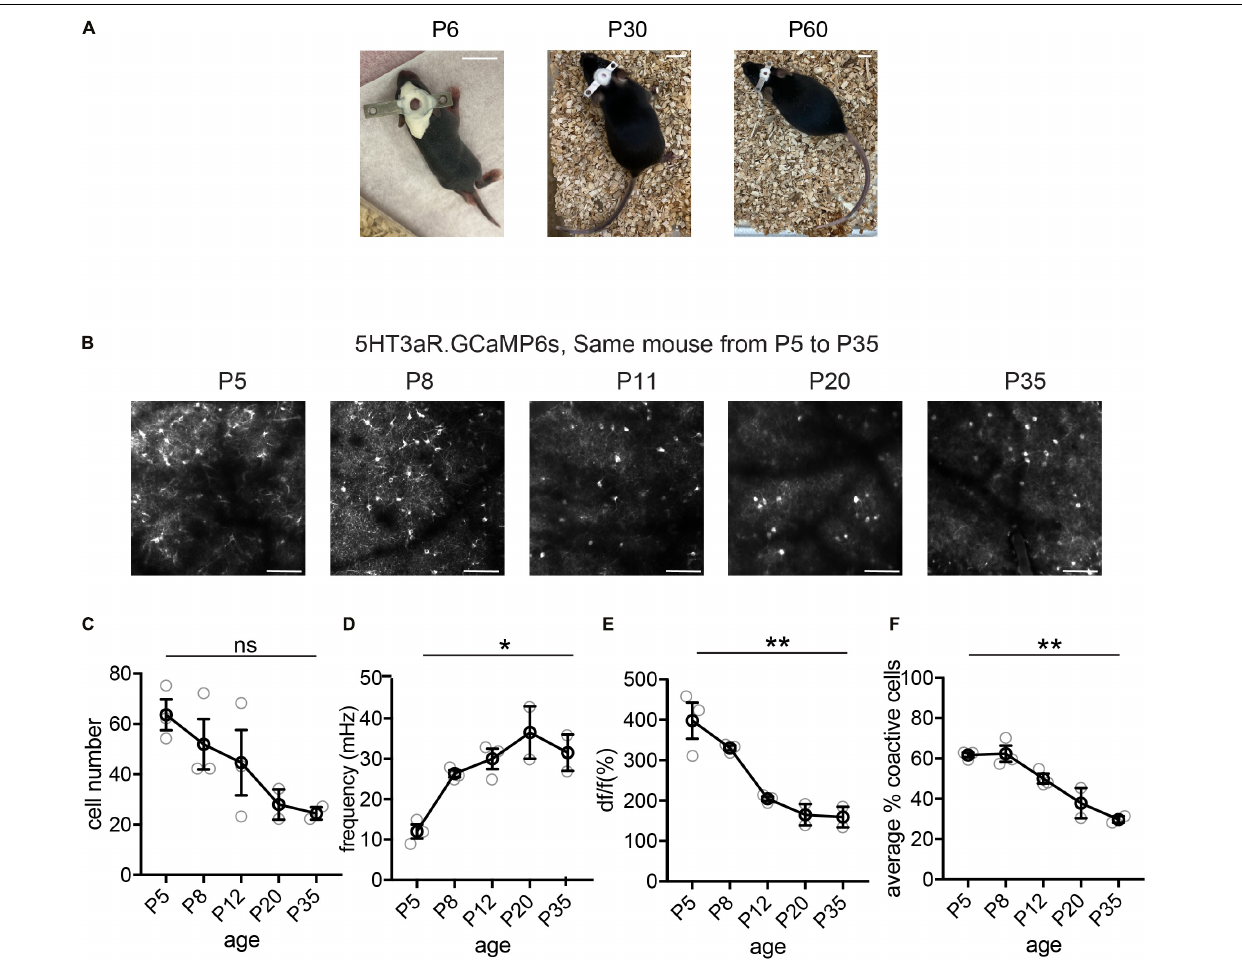
FIGURE 3 | Longitudinal imaging of L1 5HT3aR interneurons. (A) Representative image of a mouse with head plate implant at P6, P30, and P60. Scale = 10 mm. (B) Representative two-photon field of views (FOV)s from a 5HT3aR.GCaMP6s mouse images at P5, P8, P11, P20, and P35. Scale = 100 µ m. (C) Quantification of the number of active cells in a FOV at P5, P8, P11, P20, and P35. Kruskal–Wallis test, p = 0.086. n = 3 FOVs for P5, P8, and P11, n = 2 FOVs for P20 and P35, from three different longitudinally imaged animals. (D) Quantification of the average event frequency for each cell. * p = 0.034. (E) Quantification of the average event amplitude for each cell. ** p = 0.013. (F) Quantification of the average percentage of coactive cells. ** p = 0.015. Black circles indicate mean from all videos; gray circles indicate individual videos; error bars indicate